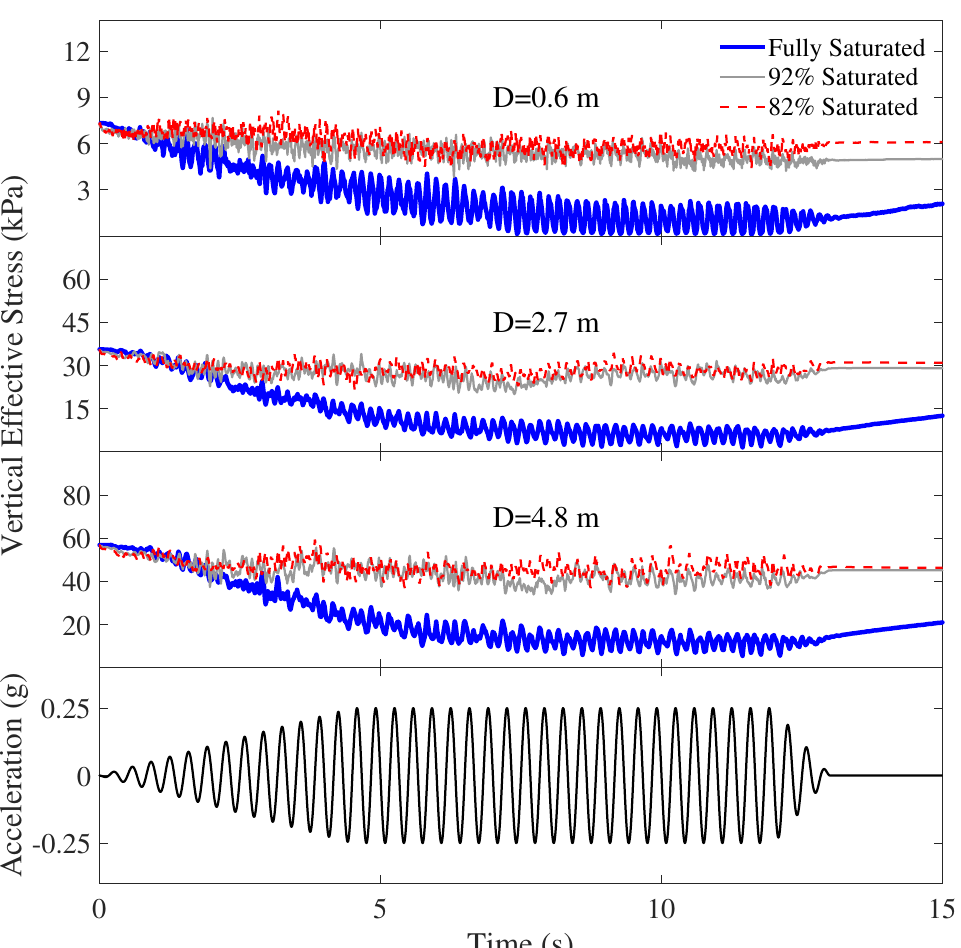
Figure 9. Time histories of the vertical effective stress at selected depth locations for soil deposits with different degrees of